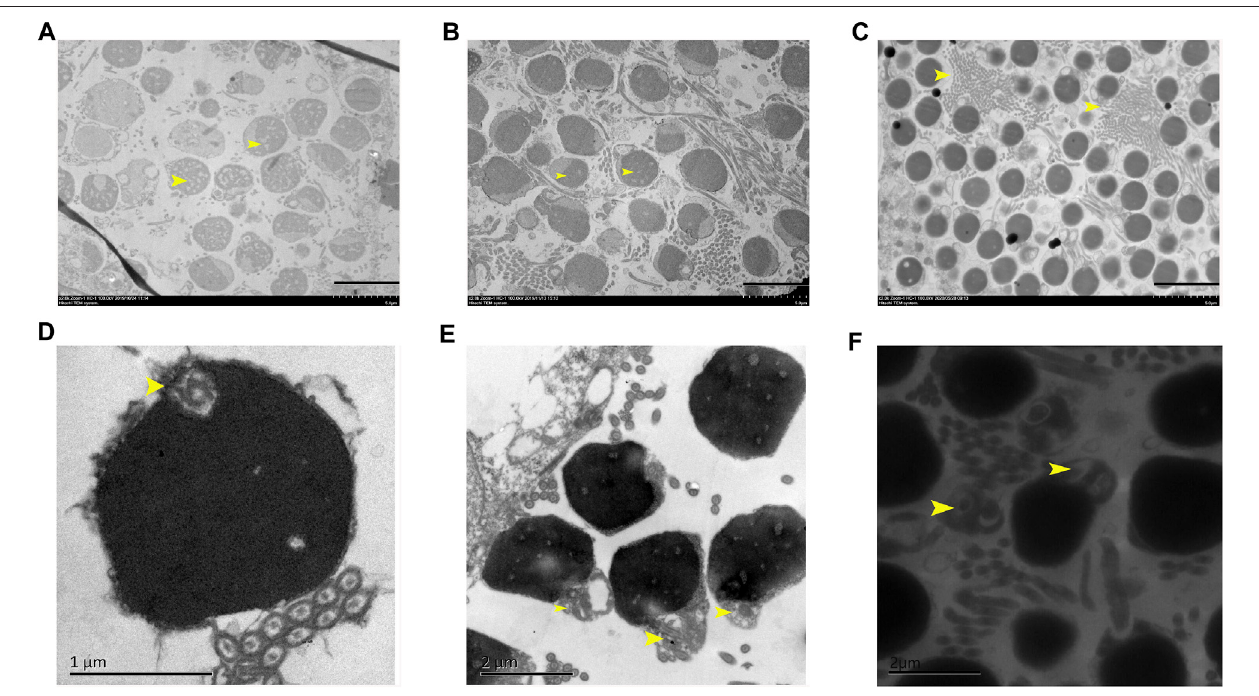
FIGURE 3 | Abnormal structural features in 3nDTCC sperm. (A) The nuclei are heavily vacuolated; (B) the head shape is irregular; (C) a large number of spermatozoa axial cross sections are concentrated; small centriolar complex (D) , abnormal link of head with fl agella (E) and a spermatozoa with two fl agella (F) are magni fi ed. Bar in A, B, C is 5 μ m; bar in D is 1 μ m; bar in E and F is 2